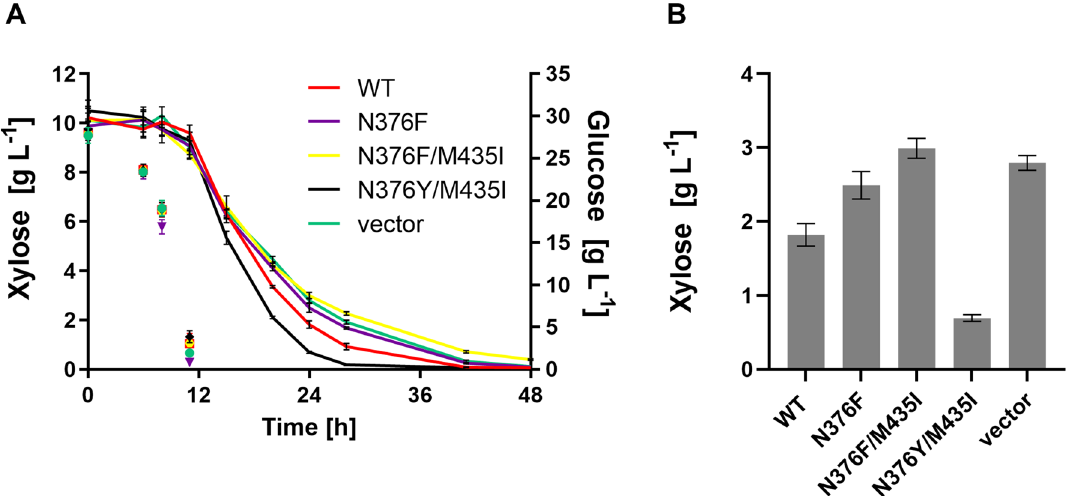
Figure 3. Fermentation of the industrial strain SRY027 expressing different Gal2 variants. The Gal2 constructs (wildtype—WT or the indicated mutants) were expressed from multicopy plasmids in the strain SRY027. ( A ) The consumption of xylose (starting concentration 10 g L −1 , solid lines; plotted on the left Y-axis) and glucose (starting concentration 30 g L −1 ; symbols only, plotted on the right Y-axis) was measured via HPLC analysis. The mean values and standard deviation of three independent cultures are shown. The error bars may be smaller than the symbols. ( B ) Residual xylose concentration measured after 24 h of fermentation is shown. All values differ significantly from the wildtype (Tukey’s multiple comparisons test, P <